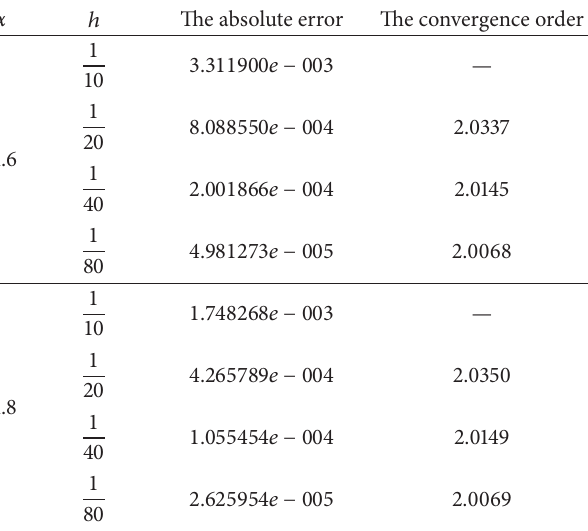
Table 1: The absolute errors and convergence orders of Example 1 by numerical scheme (46).